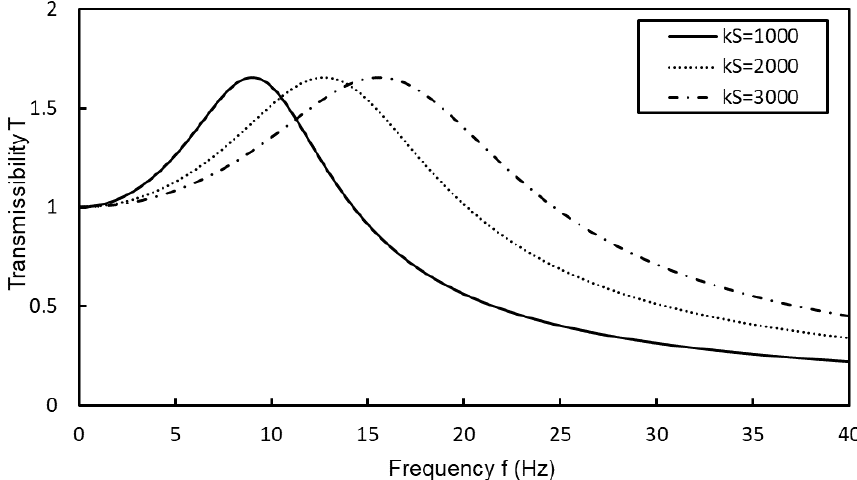
Figure 14. Transmissibility of the hydraulic viscous damper module of VEAM with varying k s